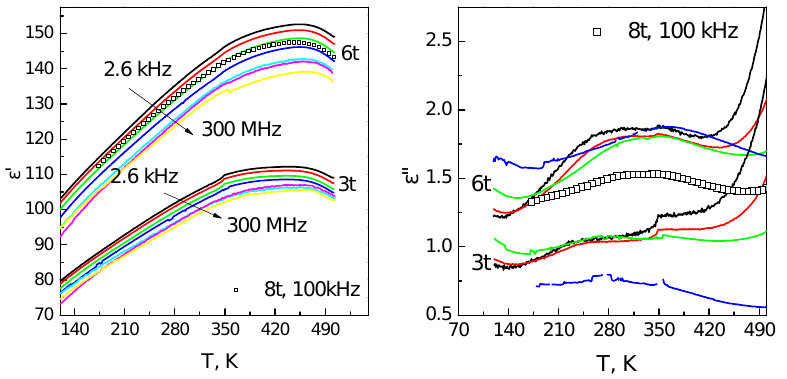
Figure 5. Real and imaginary parts of the dielectric permittivity as a function of temperature.